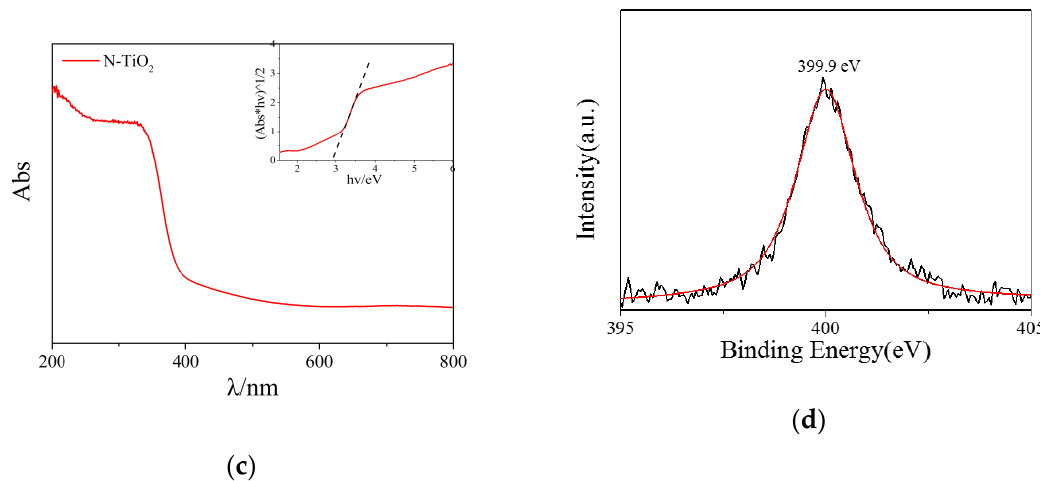
Figure 1. Characterization of N-TiO 2 catalysts ( a ) XRD patterns, ( b ) TEM image, ( c ) UV-Vis spectrum, ( d ) N1s binding energy peak.